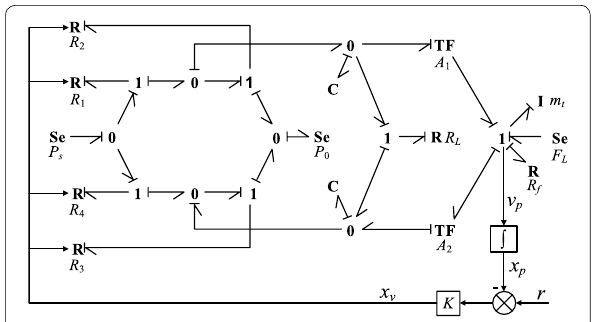
Figure 4 Bond graph of the hydraulic servo